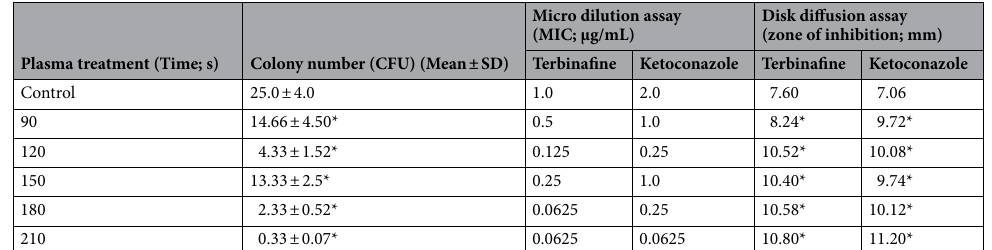
Plasma treatment (Time;